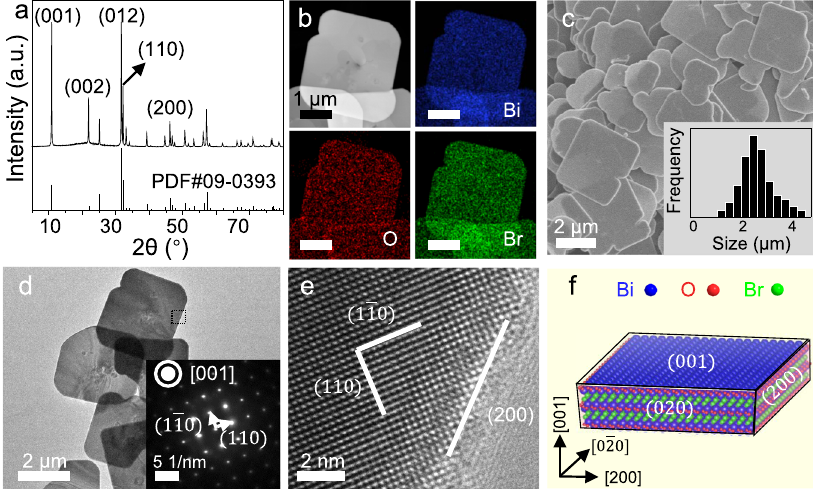
Fig. 1 Microscopic characterization of BiOBr platelets. a XRD pattern, b EDS maps, c SEM morphology (inset: statistical histogram of the lateral size distributions of BiOBr platelets), d TEM image of BiOBr platelets. A typical selected-area electron diffraction (SAED) pattern of BiOBr platelets is given in the inset. e Enlarged HRTEM image recorded at the edge of a platelet. f Schematic diagram depicting the crystal habit of BiOBr platelets. Source data are provided as a Source Data fi